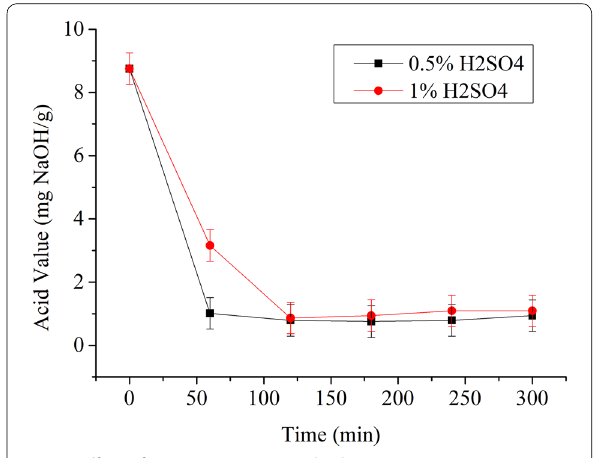
Fig. 3 Effect of reaction time on acid